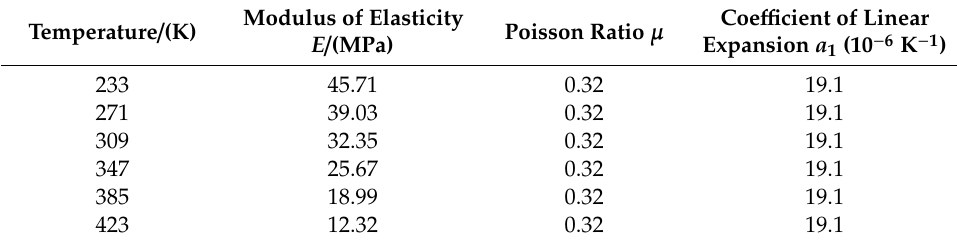
Table 12. Material parameters of the SAC305 solder